Question: What style of plot is this figure drawn as?
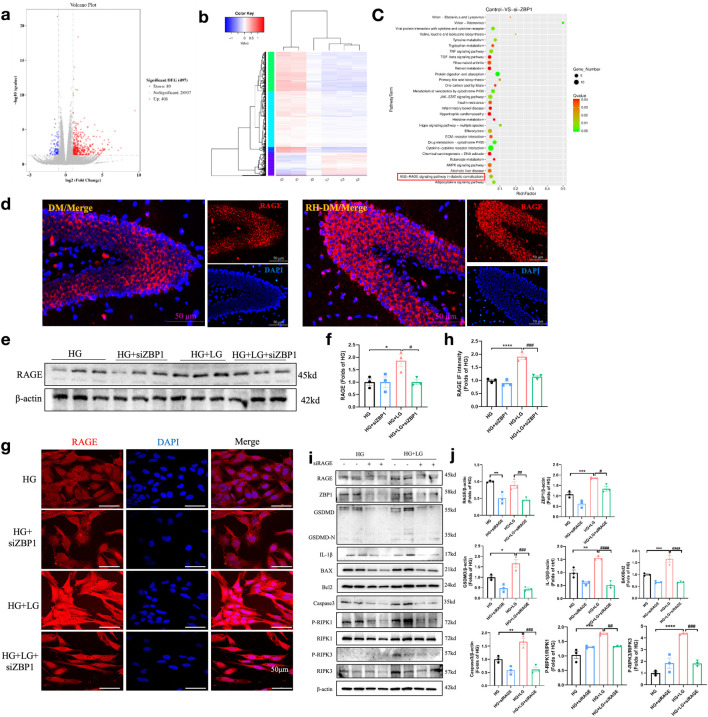
Answer: heatmap